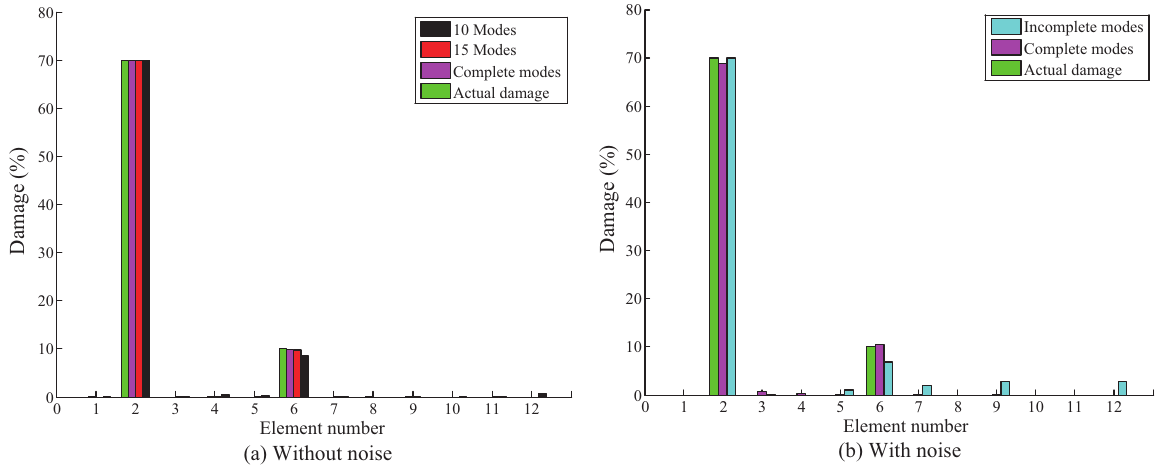
Fig. 4. Damage distribution of continuous beam using the complete and incomplete modal data in Scenario